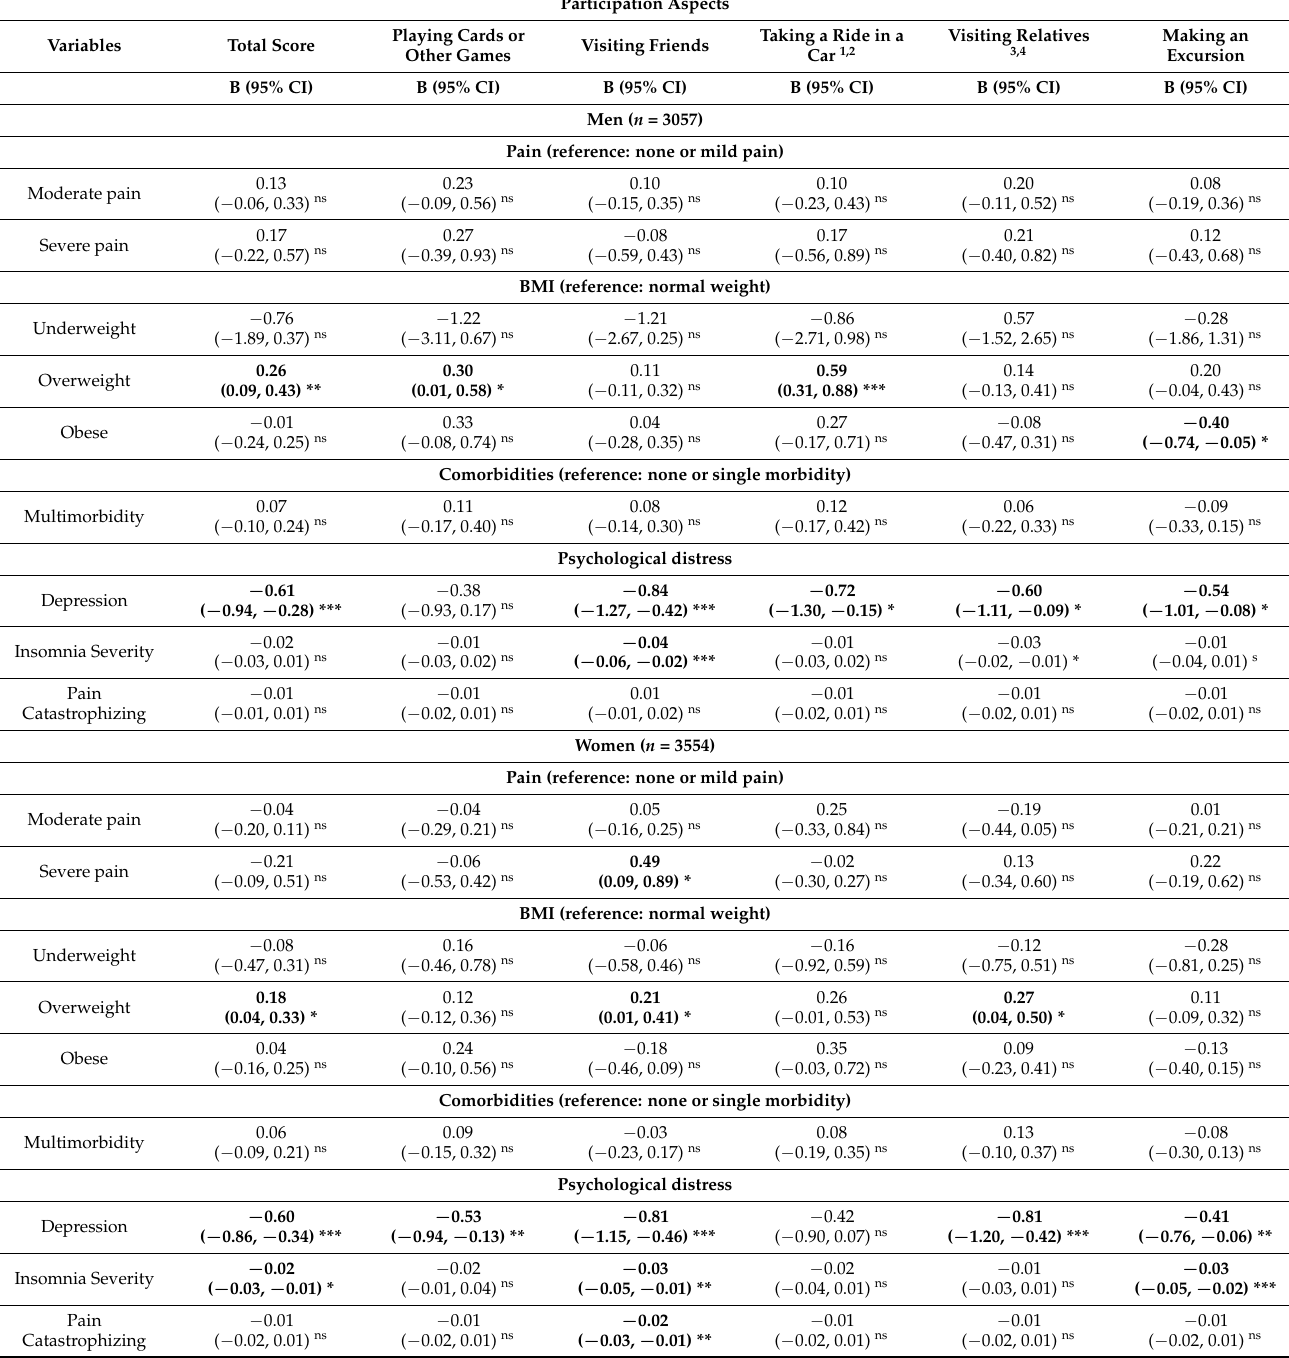
Table 4. Results of multivariable regression analysis on total participation and participation aspects stratified by gender adjusted for age, marriage status, education level, and yearly income